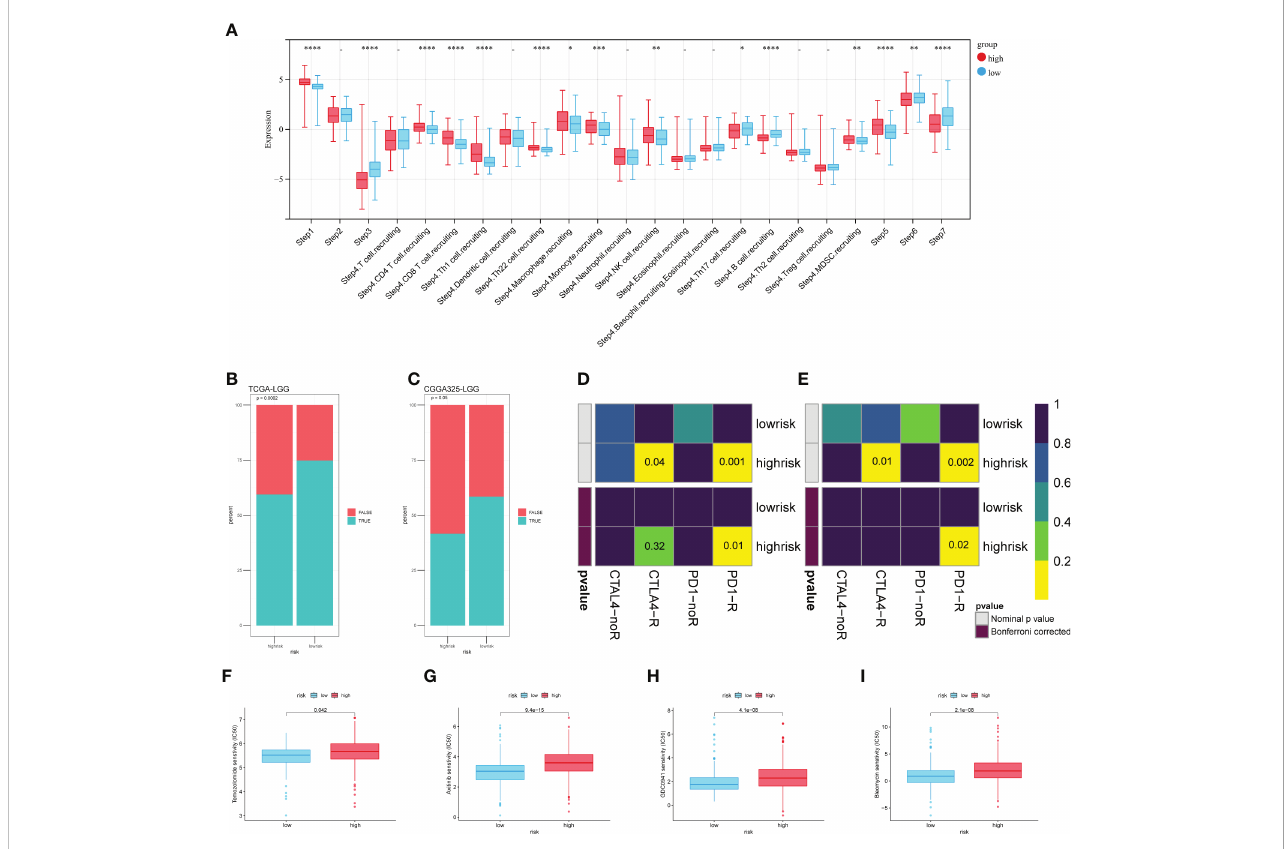
FIGURE 7 Risk score-based analysis of the strati fi able immune response and chemotherapy ef fi cacy. (A) The TIP system quanti fi ed seven steps of the antitumor immune response. (B, C) Predicted response of TIDE to immune checkpoint inhibitors. (D, E) Comparing the effectiveness of PD1 and CTLA4 in response to different risk groups. (F – I) The sensibility of chemotherapeutic drugs (F) Temozolomide, (G) Axitinib, (H) GDC0941, and (I) Bleomycin. (*p < 0.05, **p <0.01, ***p <0.001, ****p